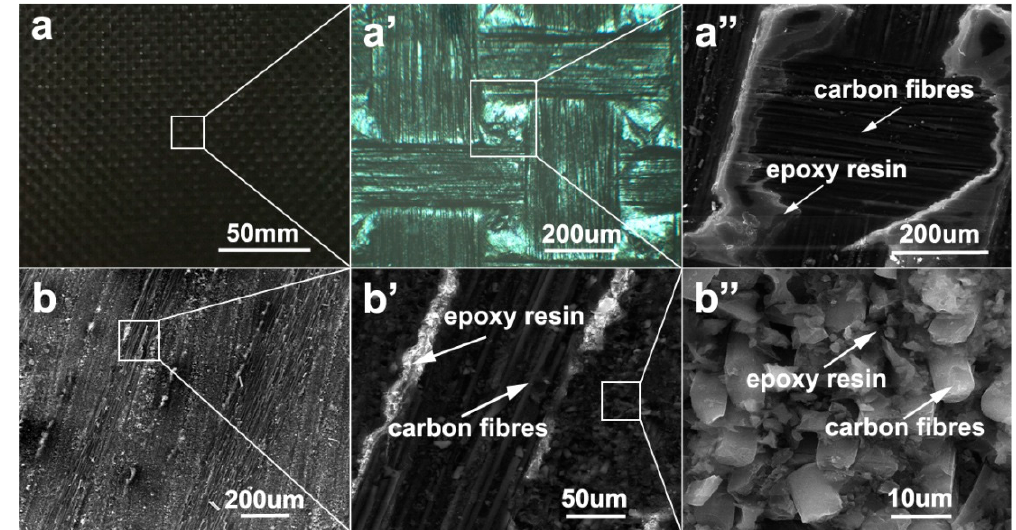
Figure 2. The structures of CFRP waste: ( a )–( a ’’) surface structures, ( b )–( b ’’) cross-sectional structures.